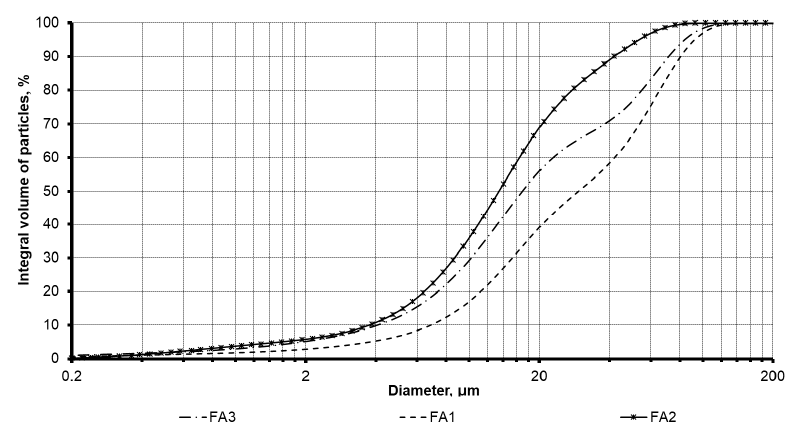
Figure 1. Particle size distribution of the investigated fly ash.